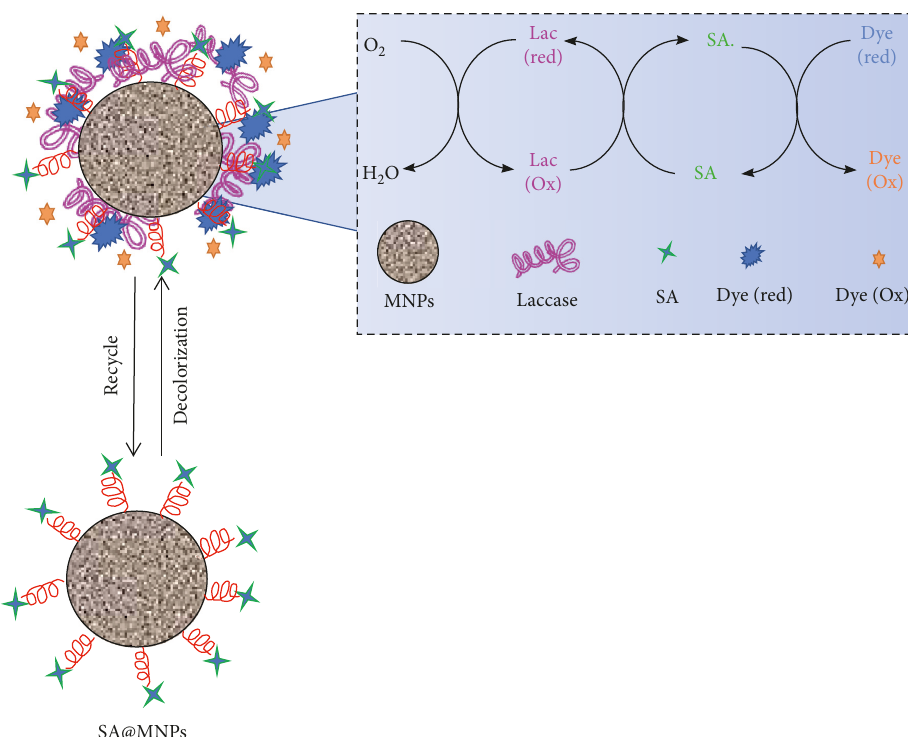
Scheme 2: Schematic illustration of the catalytic cycle of